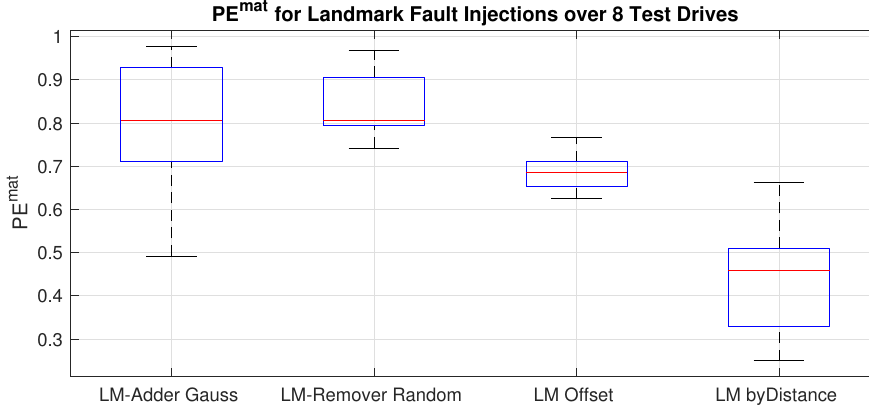
Figure 8. Distribution of perturbation errors per matching perturbation